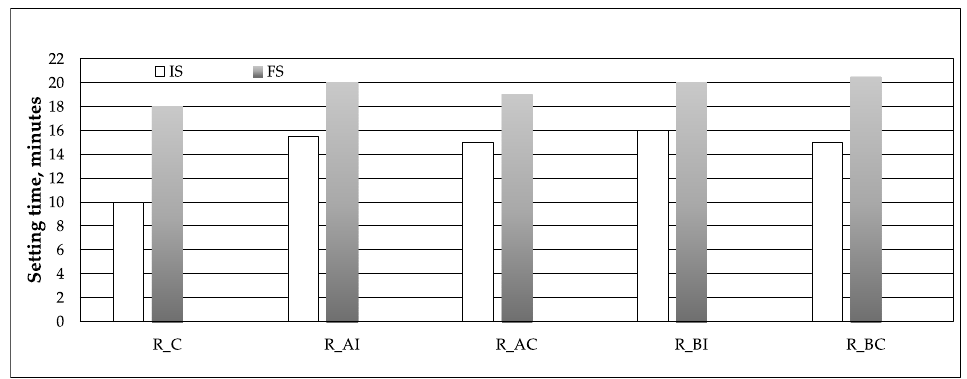
Figure 6. Ettringite, hydrotalcite and belite concentrations (determined by the Rietveld method) for R_C ( a ), R_AI ( b ), R_AC ( c ), R_BI ( d ) and R_BC ( e ) at 2, 28, 90 and 180 days of curing. As expected, peaks related to the presence of H t , formed thanks to the hydration reaction of A or B, were found in the XRD patterns for the four ternary systems; in particular, the concentration values for H t slightly rose with the increase in hydration age. The setting times for the CSA-based systems are reported in Figure 7.